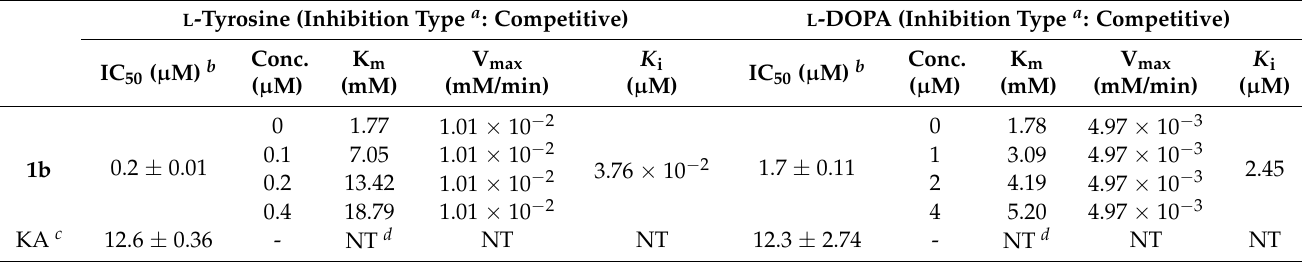
Figure 3. Mushroom tyrosinase activities of kojic acid (orange line) and 1b (blue line) according to concentrations of L -tyrosine ( A ) and L -DOPA ( B ) as substrates. Data are the means ± SEMs of three different experiments. Table 3. Tyrosinase inhibitory activities and kinetic data for 1b